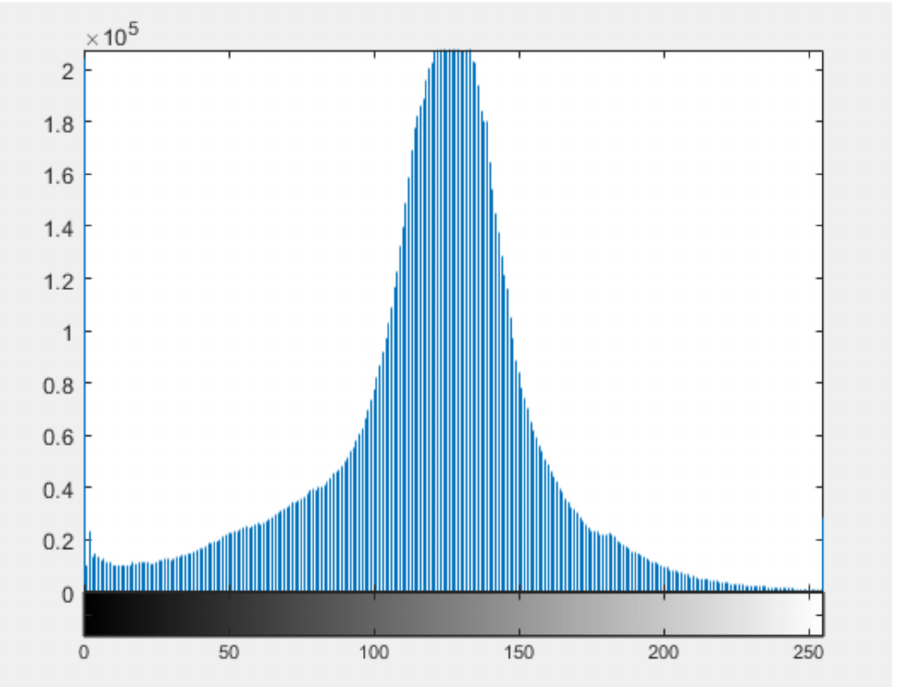
Figure 6. Flat-field correction histogram